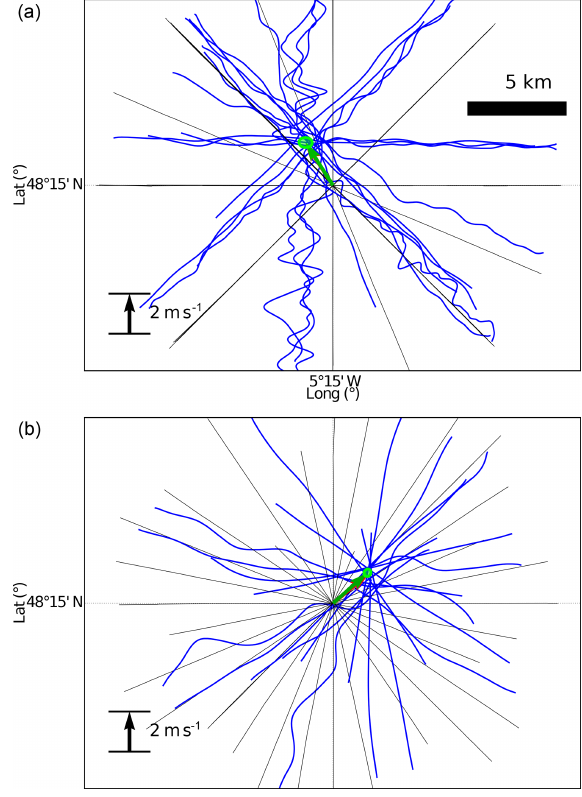
Figure 12. Plots of the Ka-band Doppler velocity signal on (a) 22 and (b) 24 November 2018. The flight tracks are marked as thin black lines. For each flight track, a thick blue line shifted to the right of the flight path by an amount proportional to the instanta- neous low-pass-filtered Doppler velocity represents the projection of the U GD vector along the instrument line of sight. At the begin- ning of each track data were discarded until the plane stabilized. The green arrow represents the maximum likelihood estimate of the U GD vector using the whole data set. The (almost indistinguish- able) red arrow shows the result of the least-squares sinusoidal fits shown in Fig. 13a and b. The 1 standard deviation error ellipse on the maximum likelihood estimate is represented in